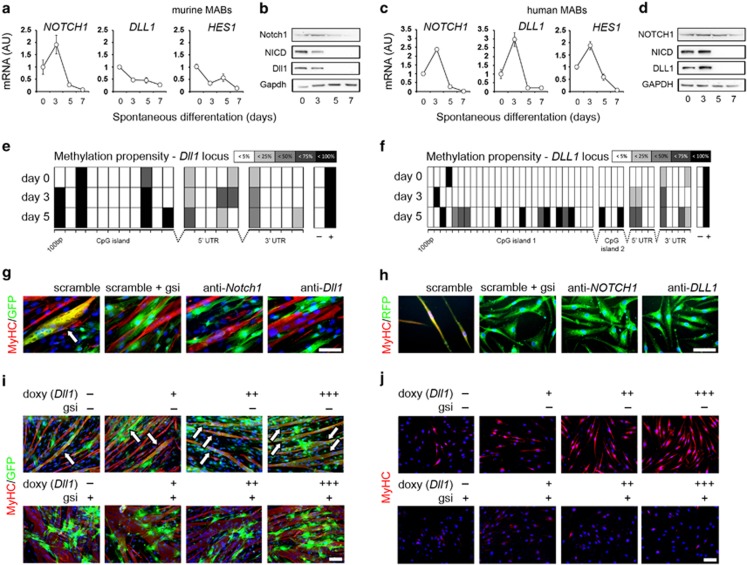
The axis Dll1-Notch1 regulates the in vitro myogenic potential of murine and human MABs. (a–d) Expression levels of Notch1/NOTCH1, Dll1/DLL1 and Hes1/HES1 (Notch1 activation reporter), and WB analysis of Notch1/NOTCH1, its activated form (Notch1/NICD) and Dll1/DLL1 in murine and human MABs over time during spontaneous differentiation in vitro. Expression levels are reported in arbitrary units (AU) as fold change versus day 0. (e, f) Summary array of methylation propensity along upstream CpG islands (one in the murine locus, two in the human), 5′-UTR and 3′-UTR of Dll1/DLL1 genomic loci in murine and human MABs at day 0, day 3 and day 5 of spontaneous differentiation, as assayed by qPCR-based test on genomic fragments enriched in highly methylated DNA. −, unmethylated control, APC promoter; +, methylated control and propensity reference, NBR2 promoter. (g) Immunofluorescence staining on co-cultures of C2C12 myoblasts with murine MABs transduced with lentiviral vectors carrying a GFP tracer and scramble, or anti-Notch1, or anti-Dll1 interfering shRNAs. White arrows indicate chimeric GFP+/MyHC+ myotubes and MAB myogenic differentiation. Scramble and scramble +γ-secretase inhibitor (gsi) conditions represent the controls of unperturbed and chemically inhibited signaling, respectively. (h) Immunofluorescence staining on differentiated human MABs after transduction with lentiviral vectors carrying a RFP tracer and scramble, or anti-NOTCH1, or anti-DLL1 interfering shRNAs. Presence of MyHC+ mono/bi-nucleated myocytes indicate MAB myogenic differentiation. (i, j) Immunofluorescence staining to evaluate the dose-dependent effects of transient Dll1/DLL1 overexpression on the in vitro myogenic differentiation of murine and human MABs, both transduced with lentiviral vectors carrying conditional expression of the ligand under doxycycline (doxy) control; −, 0 μg/ml, basal control; +, 0.1 μg/ml; ++, 1 μg/ml; +++, 10 μg/ml. To confirm Notch signaling involvement in the observed effect, gsi-supplemented control conditions are also shown. To assess the myogenic contribution of murine MABs in co-culture with C2C12, GFP+ murine MABs have been used in this experiment. Data in charts are depicted as mean±standard deviation of ≥3 independent experiments. Scale bars indicate 100 μm